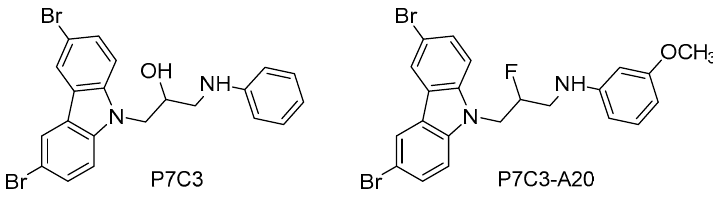
Figure 5. NAMPT activators with neuroprotective and proneurogenic effects.